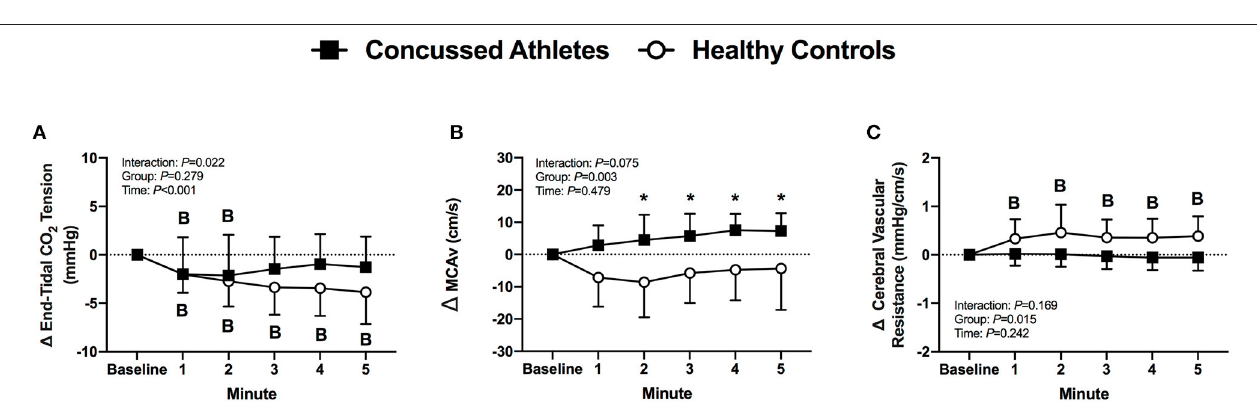
FIGURE 8 | The change from baseline in end-tidal CO 2 tension (A) , MCAv (B) and cerebral vascular resistance (C) at each minute of LBPP. Values are mean ± SD. B, different from Baseline ( P ≤ 0.05). *Different from Healthy Controls, ( P ≤